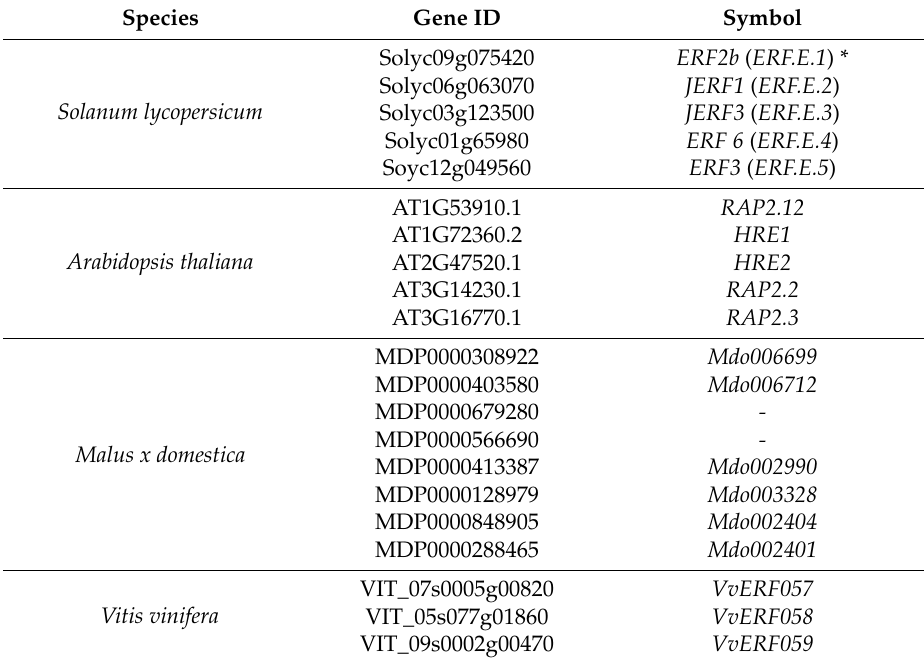
Table 2. Gene nomenclature of ethylene response factor (ERF) subgroup VII proteins in Arabidopsis , tomato, apple, and grapevine. Arabidopsis and tomato have five genes in the ERF-VII subfamily, apple has eight, and grapevine has